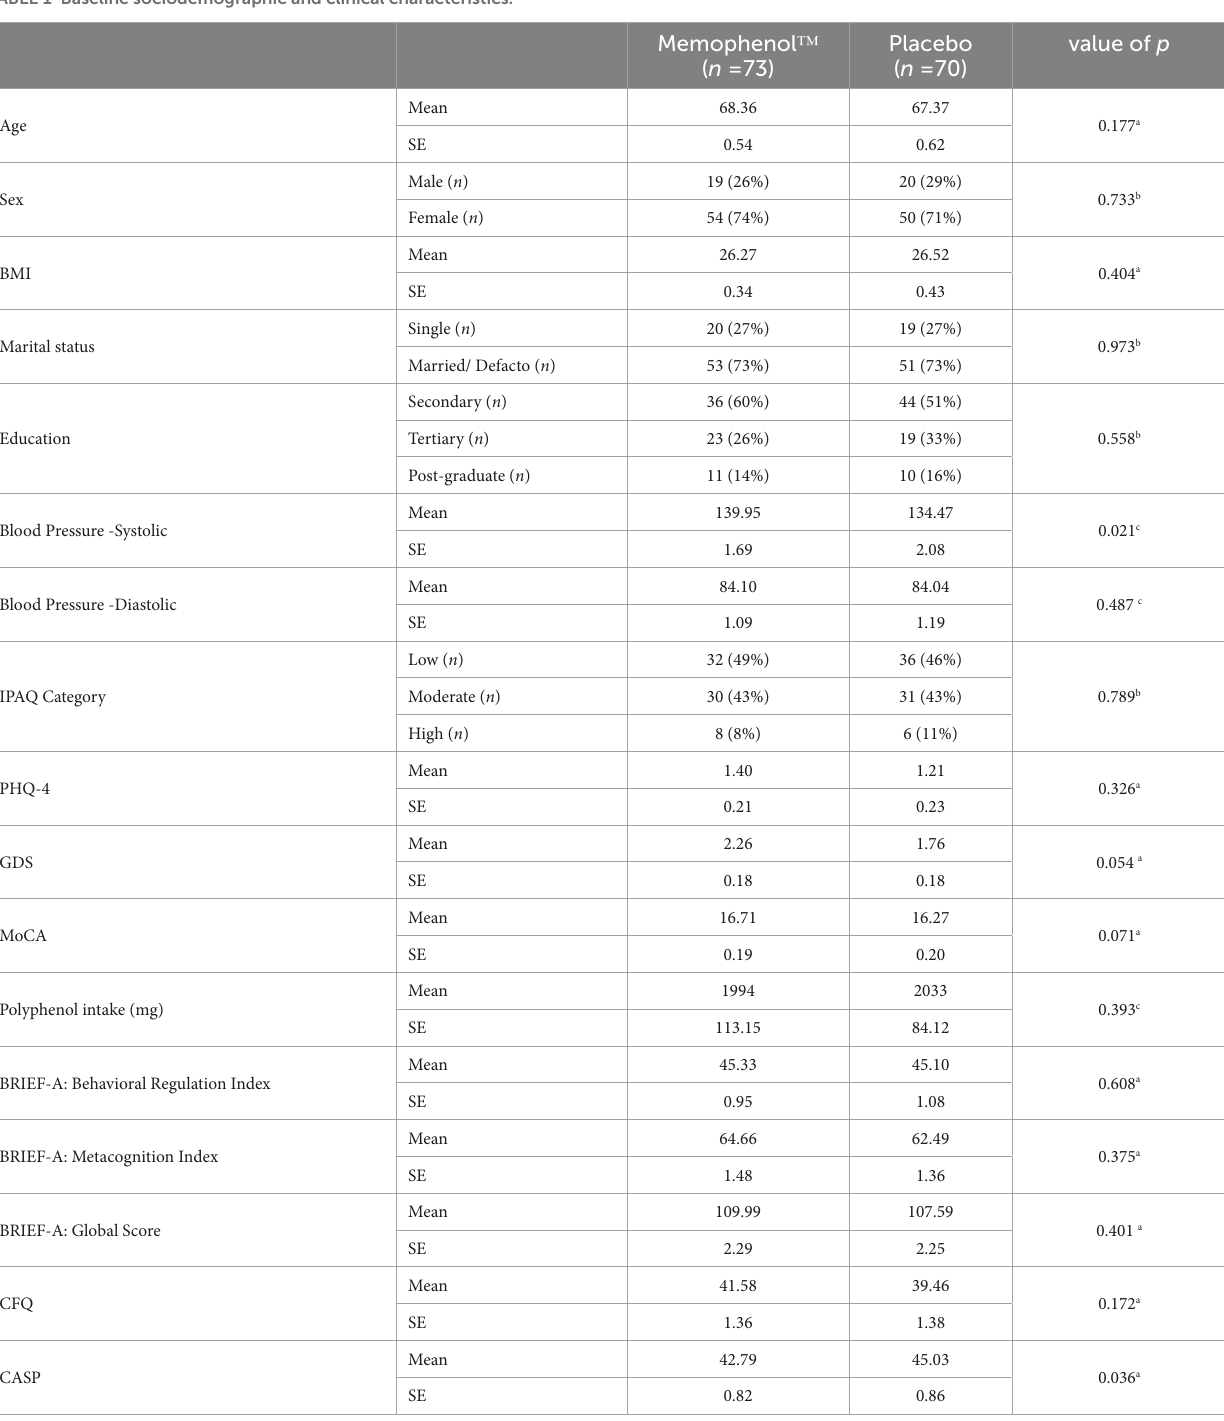
TABLE 1 Baseline sociodemographic and clinical